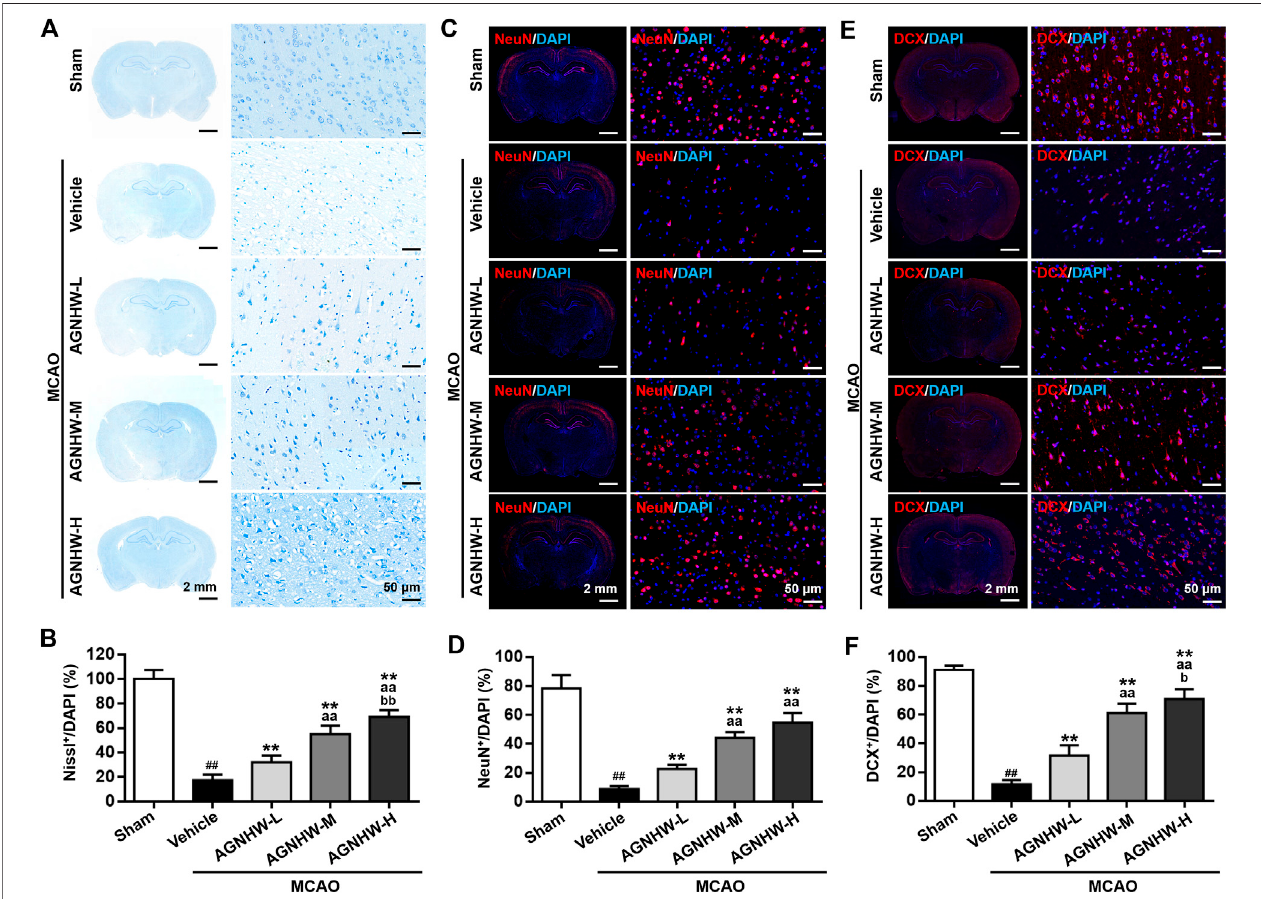
FIGURE2| AGNHWpre-treatmentrestoredneuronallossinMCAOmodel (A,B) Representativeimages( A )andstatisticalanalysisresults( B )ofNisslstaininginthe infarct area of the ischemic cortex in MCAO rats with or without pre-treatment with AGNHW (C,D) Representative images ( C ) and statistical analysis results ( D ) of immuno fl uorescent staining to visualize NeuN in the infarct area of the ischemic cortex in MCAO rats with or without pre-treatment with AGNHW (E,F) Representative images ( E ) and statistical analysis results ( F ) of immuno fl uorescent staining to visualize DCX in the infarct area of the ischemic cortex in MCAO rats with or without pre-treatment with AGNHW. N (cid:2) 5 rats per group. Data are means ± S.D. ## p < 0.01, compared with the sham group; ** p < 0.01, compared with the vehicle group; aa P < 0.01, compared with AGNHW-L group; b P < 0.05 and bb P < 0.01, compared with the AGNHW-M group.